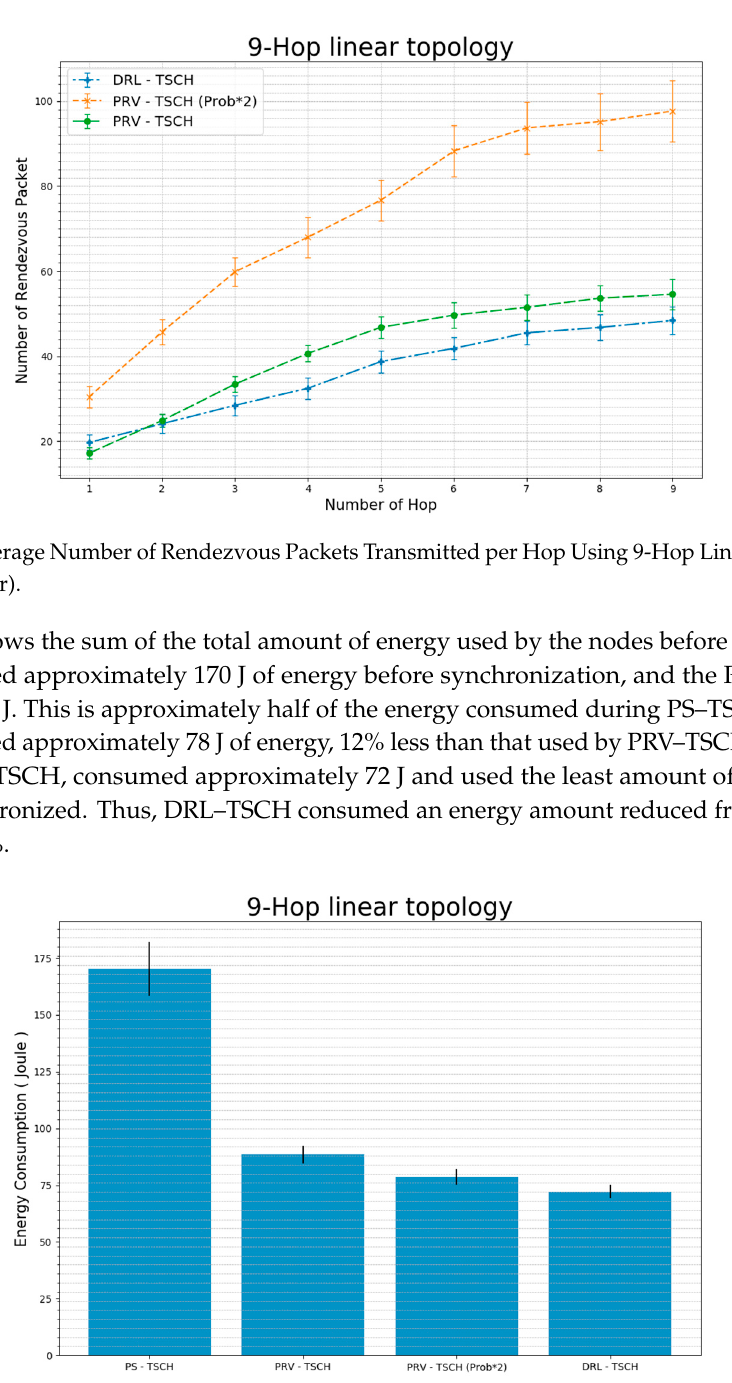
Figure 15. The Amount of Energy Consumed During Synchronization for Each Technique Using 9-Hop Linear Topology (standard error).